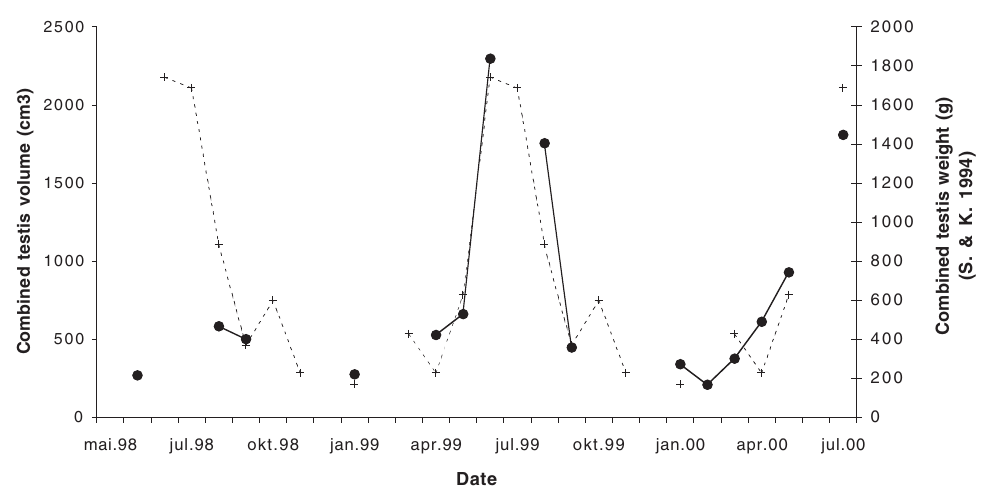
Fig. 3. Seasonal changes in the combined size of Eigil's testes, expressed as their volume to. The variation in testis mass, given by Sørensen and Kinze (1994) for Danish porpois- es is indicated for comparison as a dashed line.